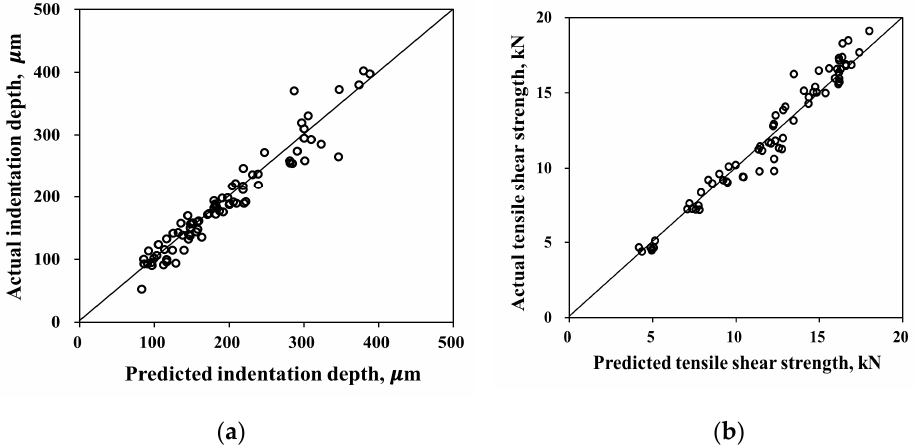
Figure 6. Comparison between the predicted value and the measured value: ( a ) indentation depth; ( b ) tensile shear strength.